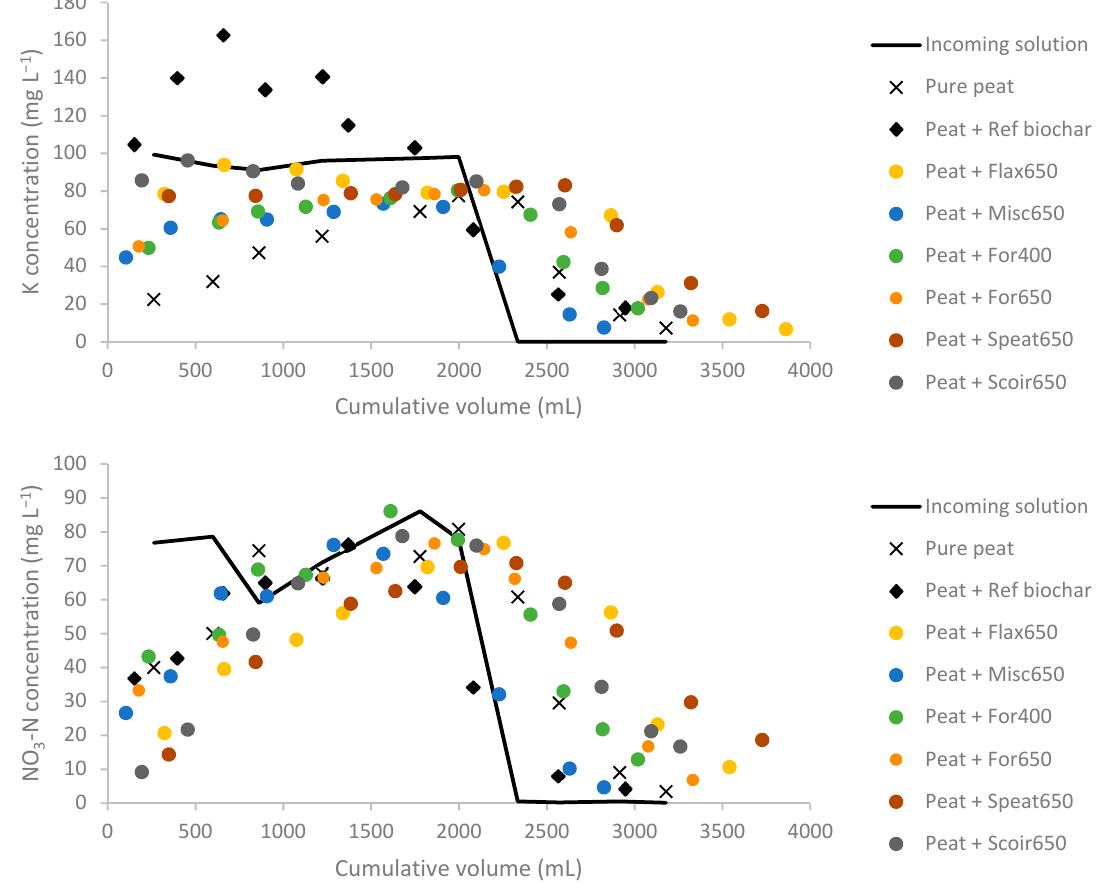
Figure 1. Average concentration (of 2 replicates) of K (above) and NO 3 -N (below) in the leachate of the peat and peat blend columns. The solid black line represents the incoming solution concentration (first phase: Fertigation solution, second phase: Water). Codes of biochars: See Table 1. Ref biochar: Reference biochar based on stone oak wood. Graphs for Na, Mg, Mn, Ca, P, NH 4 -N, SO 4 , and Cl are presented in Figure S2.